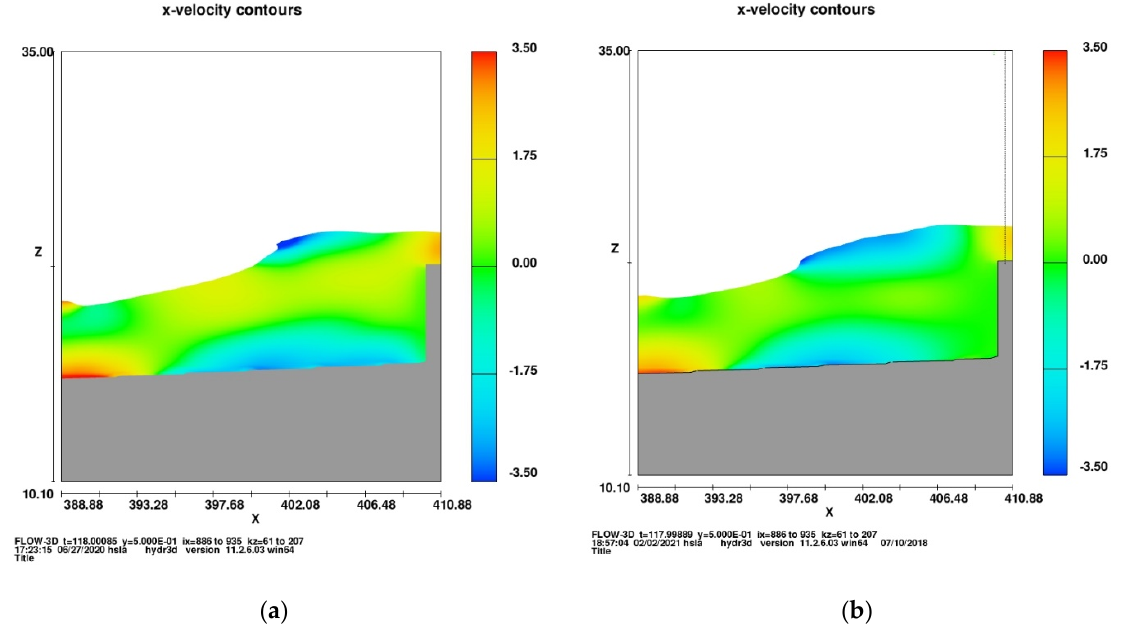
Figure 14. TEST_2 and Rc = +3.96 m. Panel ( a ) no wind; panel ( b ) U 10 30 m/s.